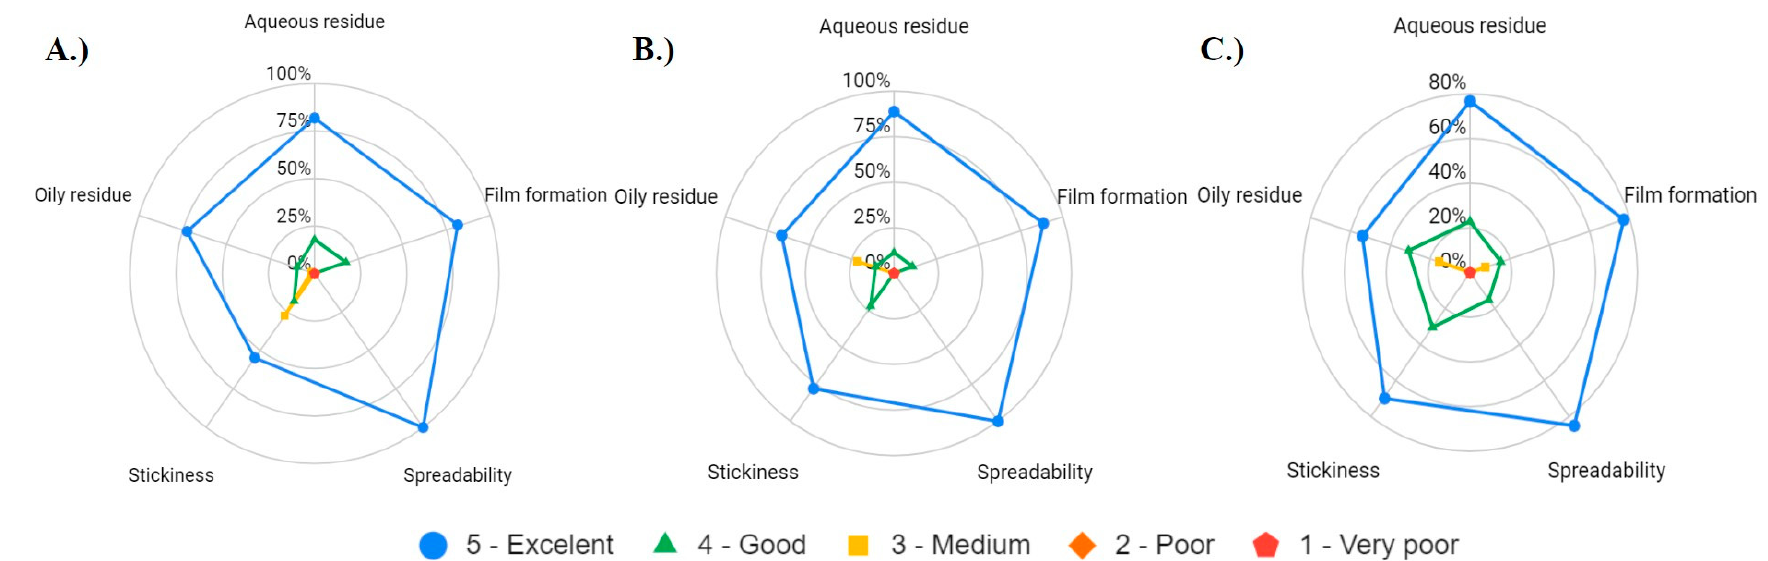
Figure 2. Evaluation of the skin feeling after application of the formulas. The attributes of the three formulas were evaluated by the 33 subjects who graded them according to their perception. The attributes evaluated were: aqueous residue, film formation, oily residue, stickiness, and the spreadability of the product. The possible grades were 5—excellent, 4—good, 3—medium, 2—poor, and 1—very poor. ( A ). Evaluation of formula A, placebo; ( B ). evaluation of formula B, containing 5% of VC-IP ® ; ( C ). evaluation of formula C, containing 15% of VC-IP ® . The more spread out an attribute in the area of the graphic is, the higher the percentage of answers that it received. The grades that do not appear in the graphs were not attributed to any of the characteristics. The percentage is related to the number of subjects, with the total number of subjects—33 women—being 100%. Source: from the